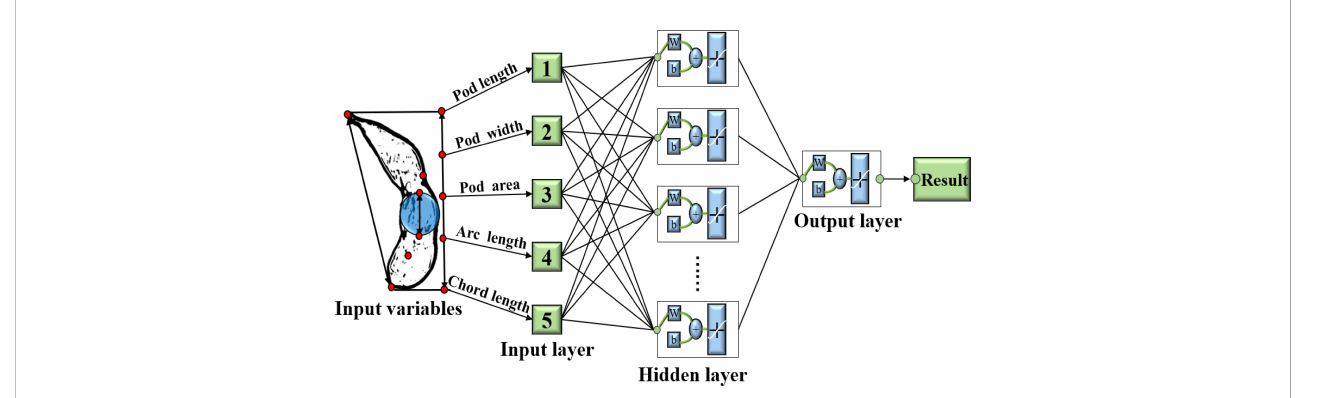
FIGURE 9 Structure diagram of neural network for estimation of single pod